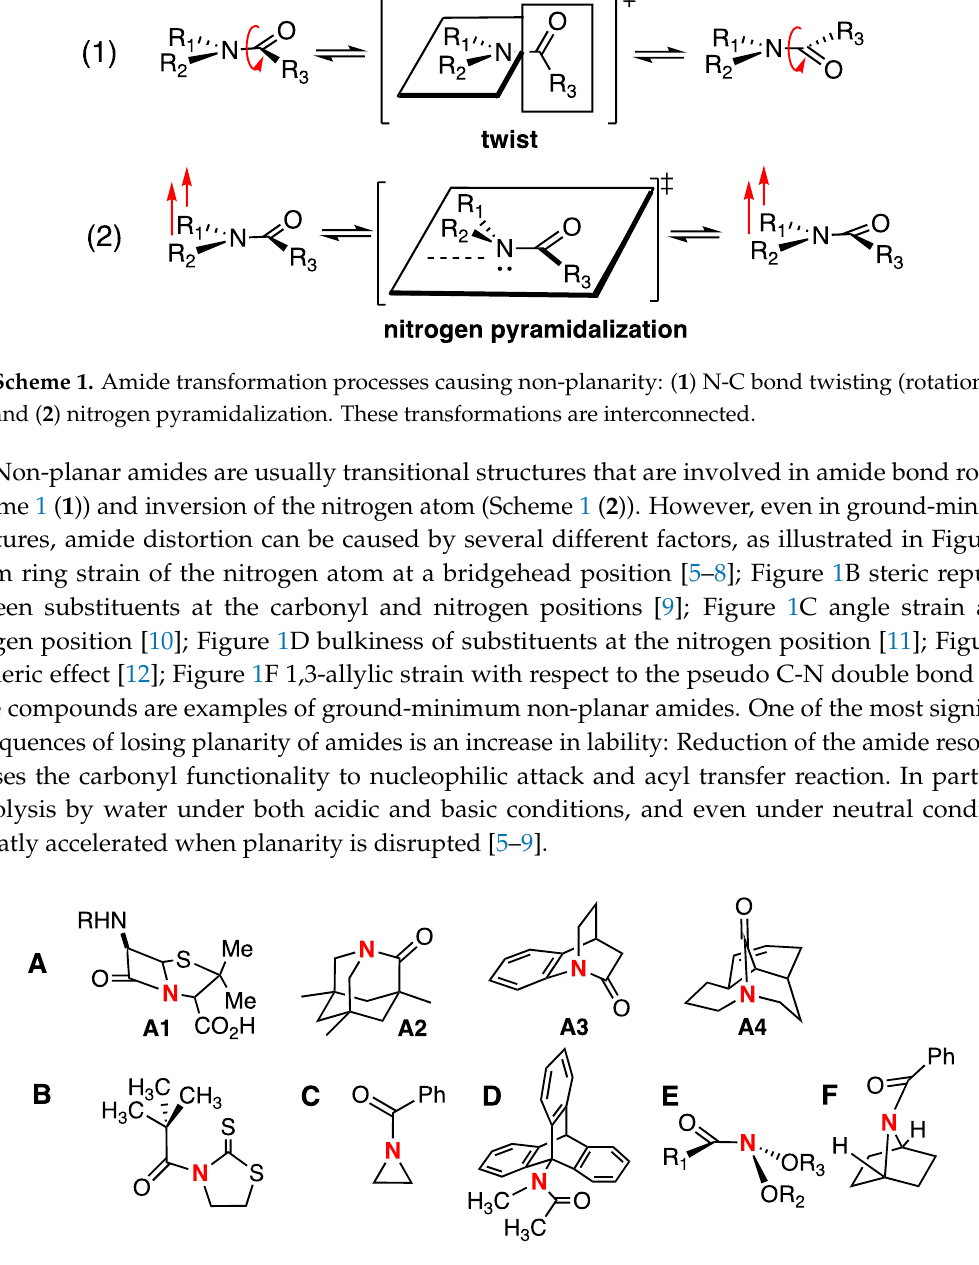
Figure 1. Some examples of non-planar amides.